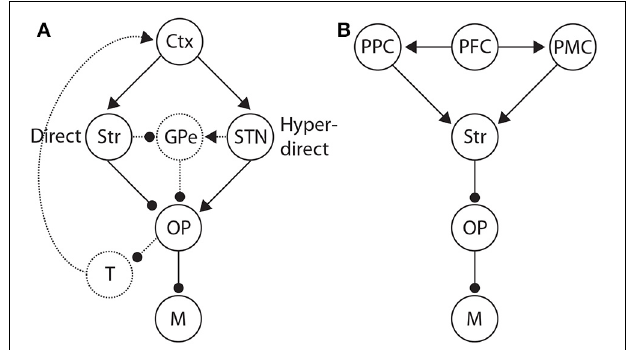
FIGURE 9 | (A) Basal ganglia (BG) pathways hypothesized to control the SAT. Along the direct pathway, cortex (Ctx) excites the striatum (Str), which in turn inhibits the BG output nuclei (OP). The output nuclei project tonic inhibition to the circuitry driving motor execution of decisions (M), i.e., choices. Less integrator activity is required to make a choice when the striatum is diffusely excited by non-integrator cortical activity. Along the hyper-direct pathway, cortex excites the subthalamic nucleus (STN), which in turn excites the output nuclei. More integrator activity is required to make a choice when STN is diffusely excited by non-integrator cortical activity. The dotted arcs through the globus pallidus (GPe) depict two further pathways that could influence the SAT in an opposite manner to the direct and hyperdirect pathways respectively. Routes back to cortex via the thalamus (T) are also depicted by dotted arcs, largely unexplored in this context. (B) Distributed system of brain regions correlated with decision making and the SAT. Data and theory suggest that executive cortical areas (here PFC) project non-selectively to integrator populations (here posterior parietal cortex PPC) and to pre-motor areas (PMC). A stronger (weaker) non-selective signal thus favors speed (accuracy) by increasing (decreasing) the strength of recurrent dynamics among integrator populations ( Figure 3B ) and by decreasing the rate of their activity required for choice